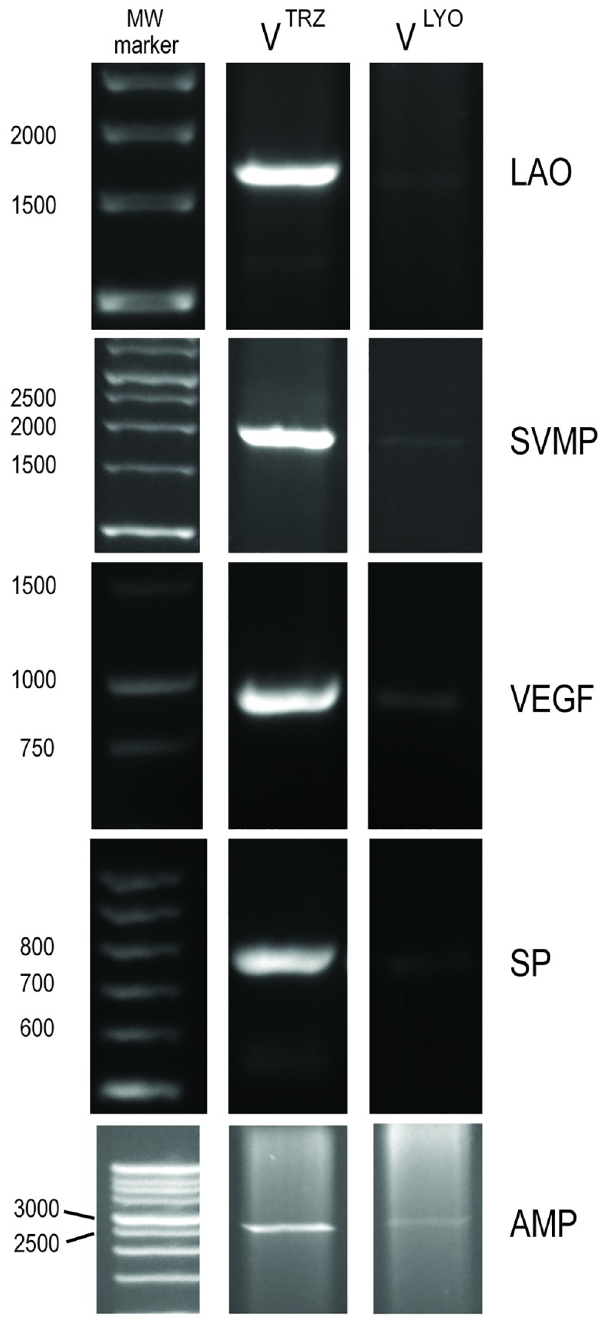
Fig 2. PCR amplification of Bitis arietans genes of distinct size and proportional representation from V LYO and V TRZ cDNA. Key: L-amino acid oxidase (LAO), snake venom metalloproteinase (SVMP), vascular endothelial growth factor (VEGF), serine protease (SP) or aminopeptidase (AMP). Molecular weight markers are shown on the left (base pairs).